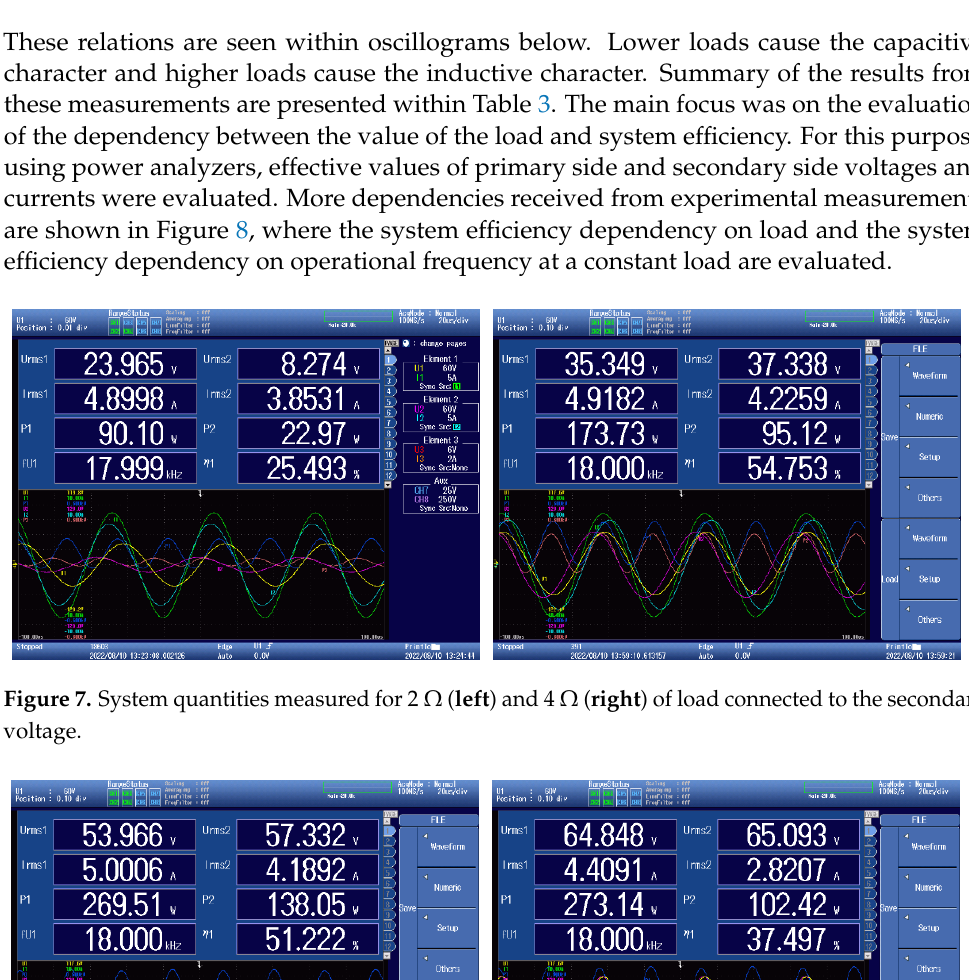
Figure 6. Laboratory set up for experimental measurements: test rig ( bottom ) and principal schematic ( top ).